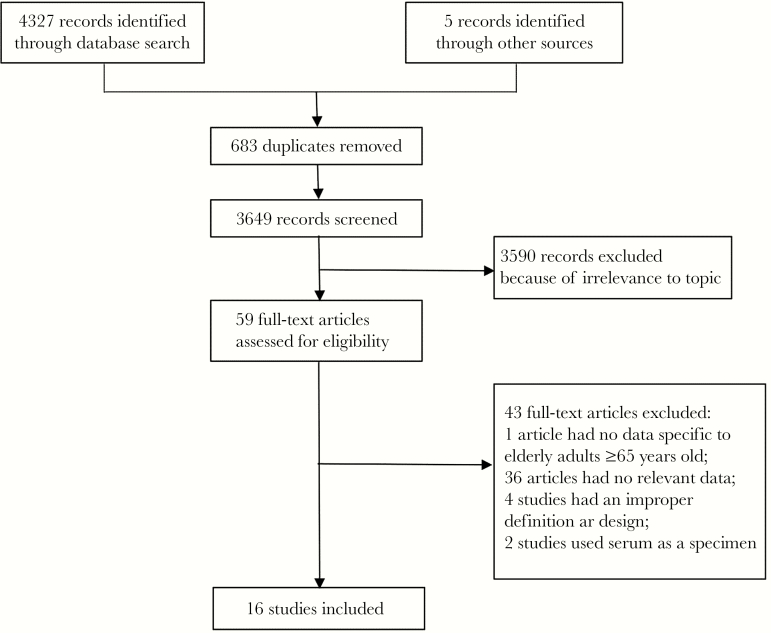
PRISMA (Preferred Reporting Items for Systematic Reviews and Meta-analyses) flow diagram of the literature search.